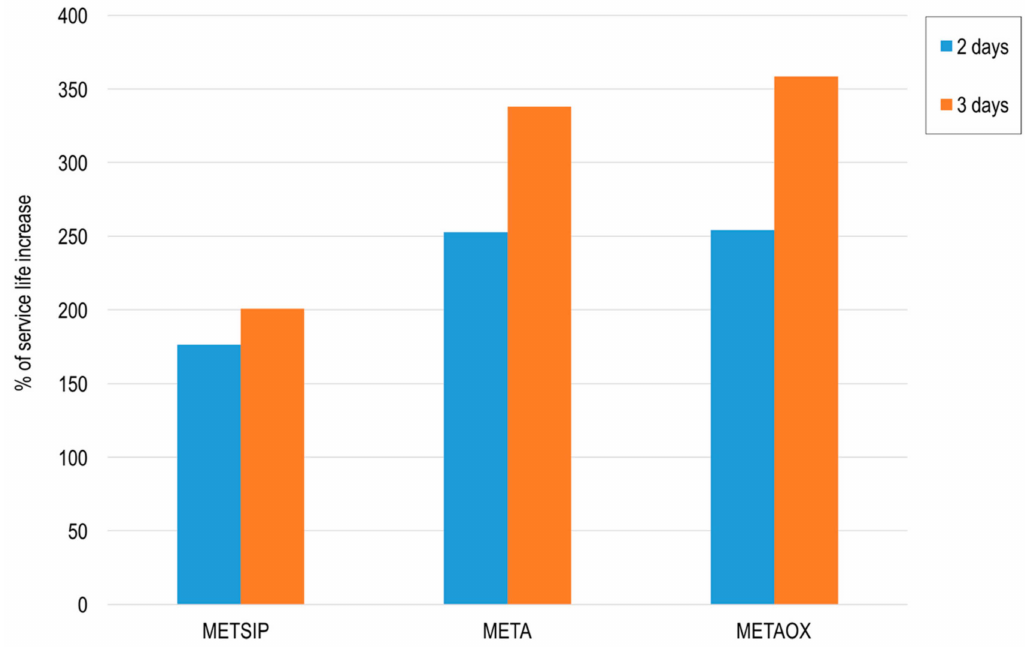
Figure 13. Percent increase of the initiation period of the studied mixes, with respect to the reference mortar, for ages of two and three days (calculated from the e ff ective di ff usion coe ffi